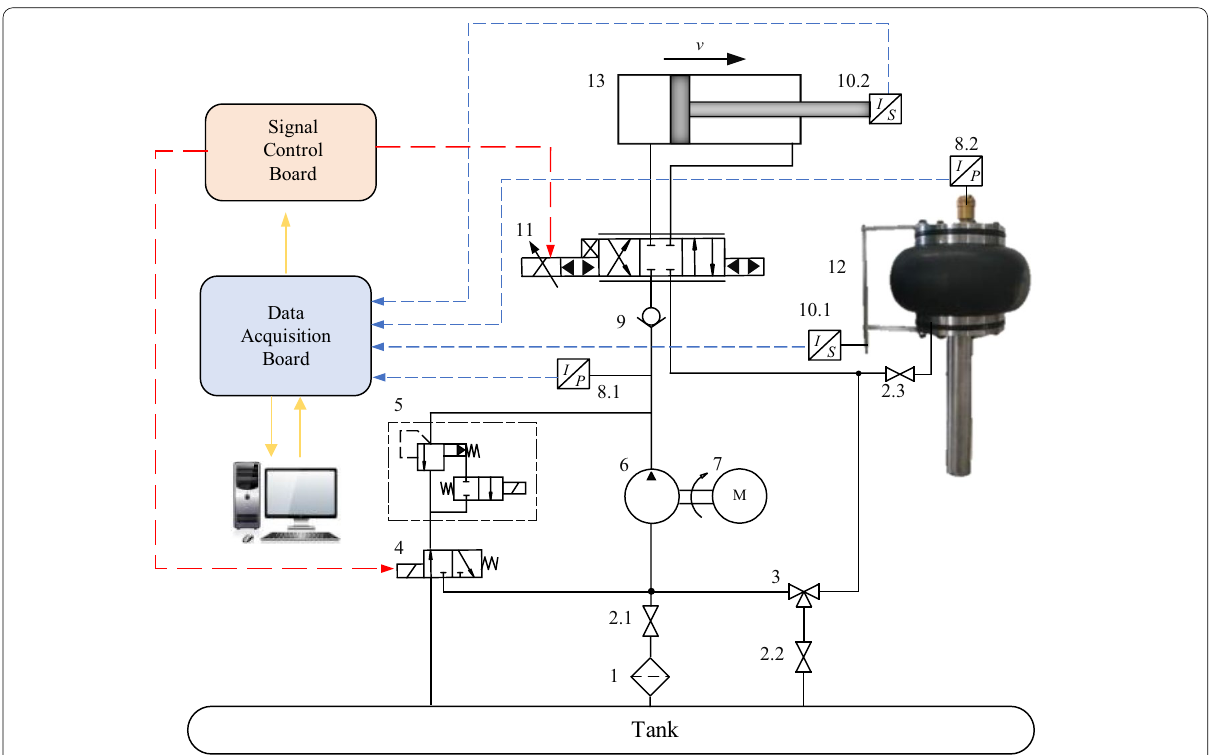
Figure 20 Principle of VVPR dynamic test. 1. Filter; 2. Shut-off valves; 3. Union tee; 4. Direction valve; 5. Unloading relief valve; 6. Hydraulic pump; 7. Electrical motor; 8. Pressure sensors; 9. One-way valve; 10. Displacement sensors; 11. Proportional reverse valve; 12. VVPR; 13 Hydraulic